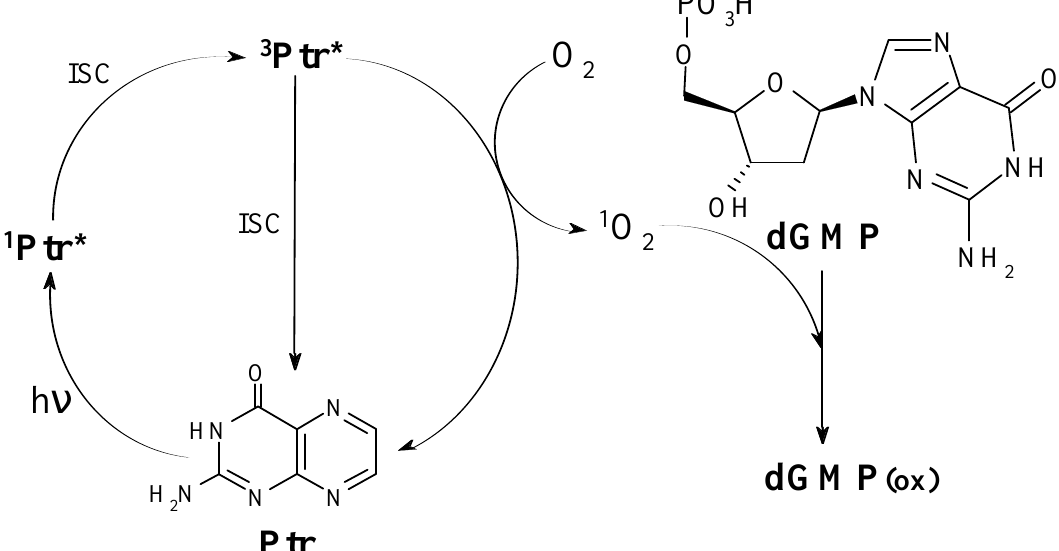
Figure 4. Oxidation of dGMP photosensitized by pterin (Ptr) through a type II